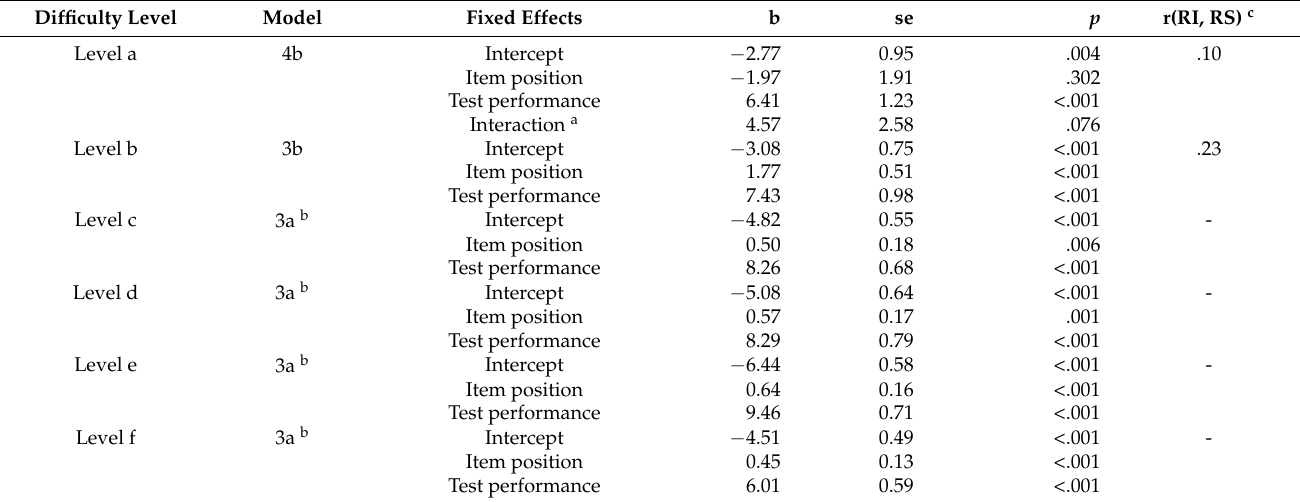
Table 3. Fixed effects and correlations between random intercept (RI) and random slope (RS) of the MLM with the dependent variable item accuracy.